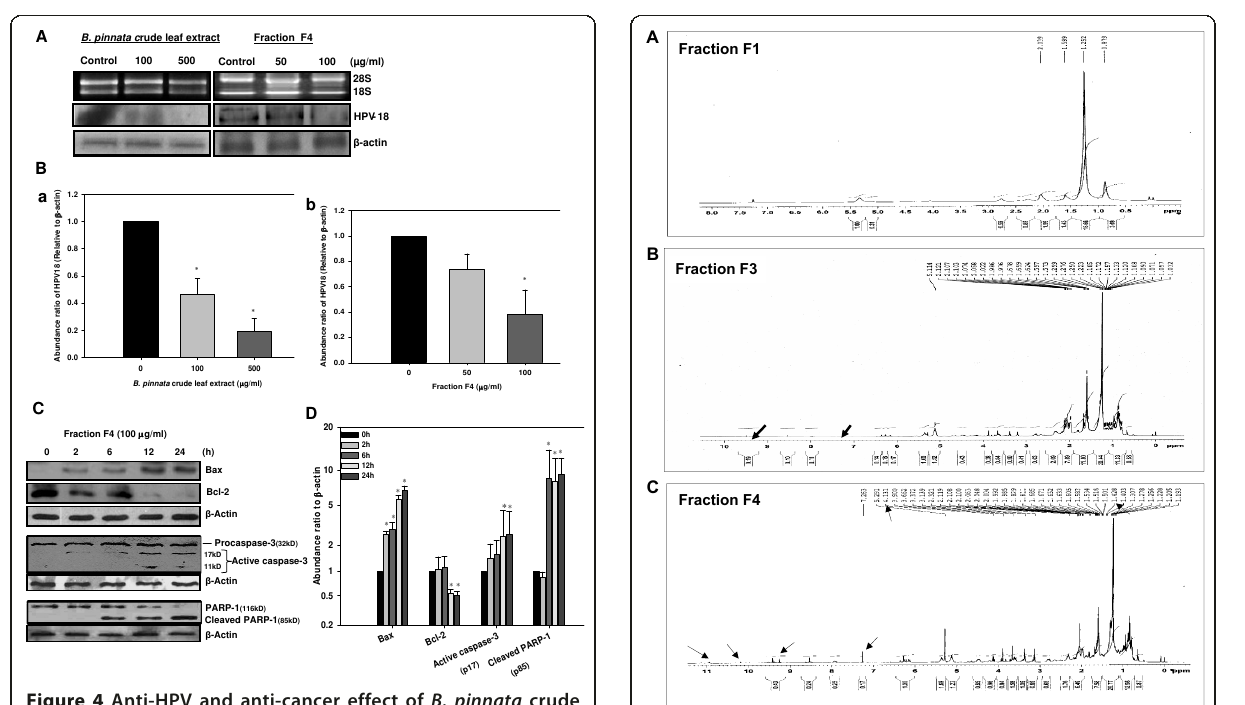
Figure 5 Functional group analysis of UV active B. pinnata fractions by Proton NMR . Fraction F1, F3 and F4 were dissolved in CDCl3 and NMR was taken at 400